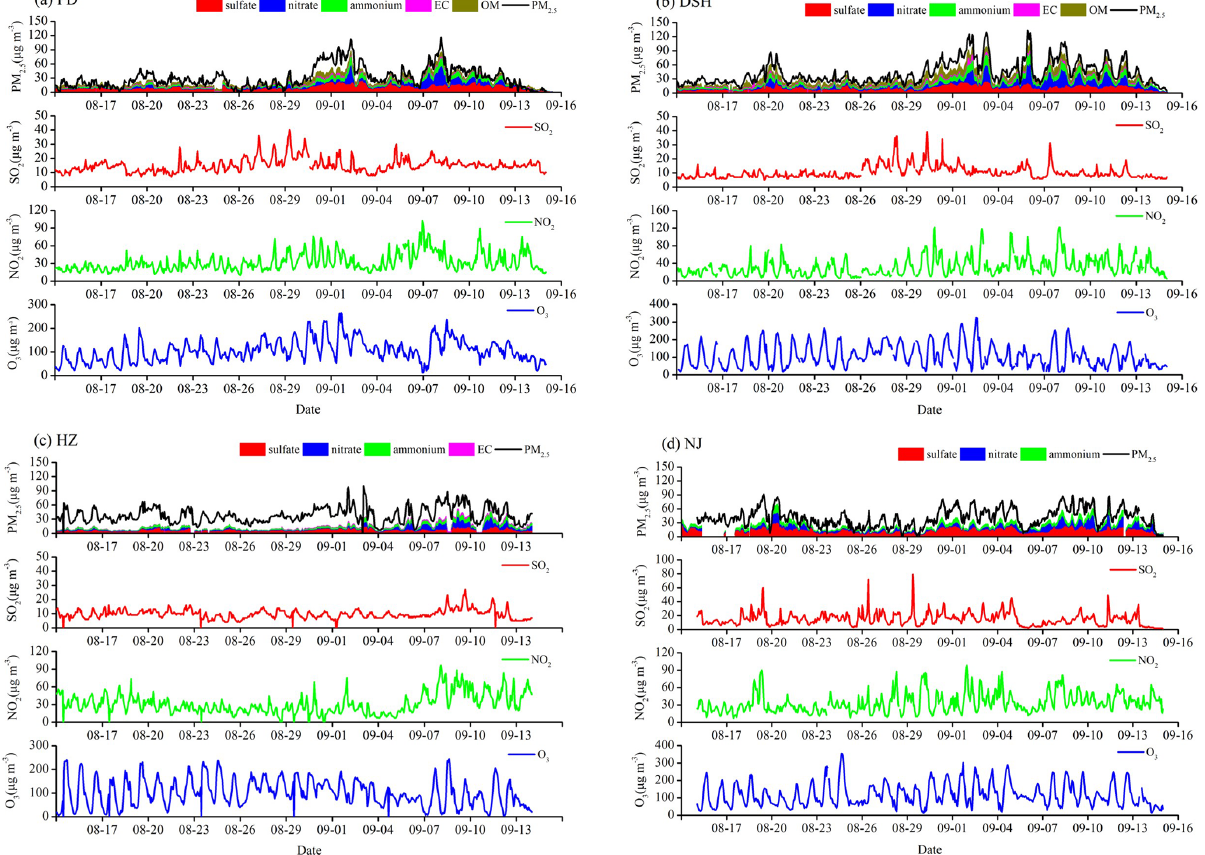
Figure 4. Observed aerosol composition and gaseous pollutant concentrations at the four supersites during Period I.